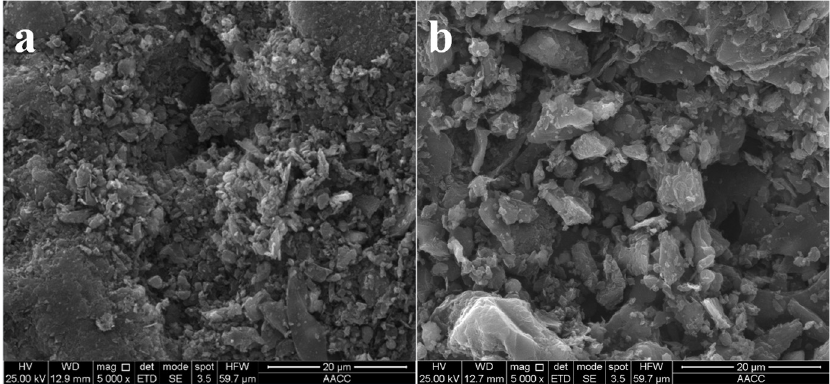
Figure 2. Surface morphologies of the coke powder with an ash content of ( a ) 27.37% and ( b ) 12.78%.